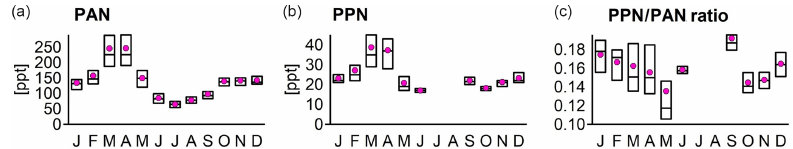
Figure 22. Boxplot of monthly variation (box top and bottom: 75th and 25th percentiles, respectively, horizontal bar: median) and monthly averages (pink) of peroxyacetyl nitrate (PAN), peroxypropyonyl nitrate (PPN), and the PPN / PAN ratio at the Zeppelin Observatory in 1994 to